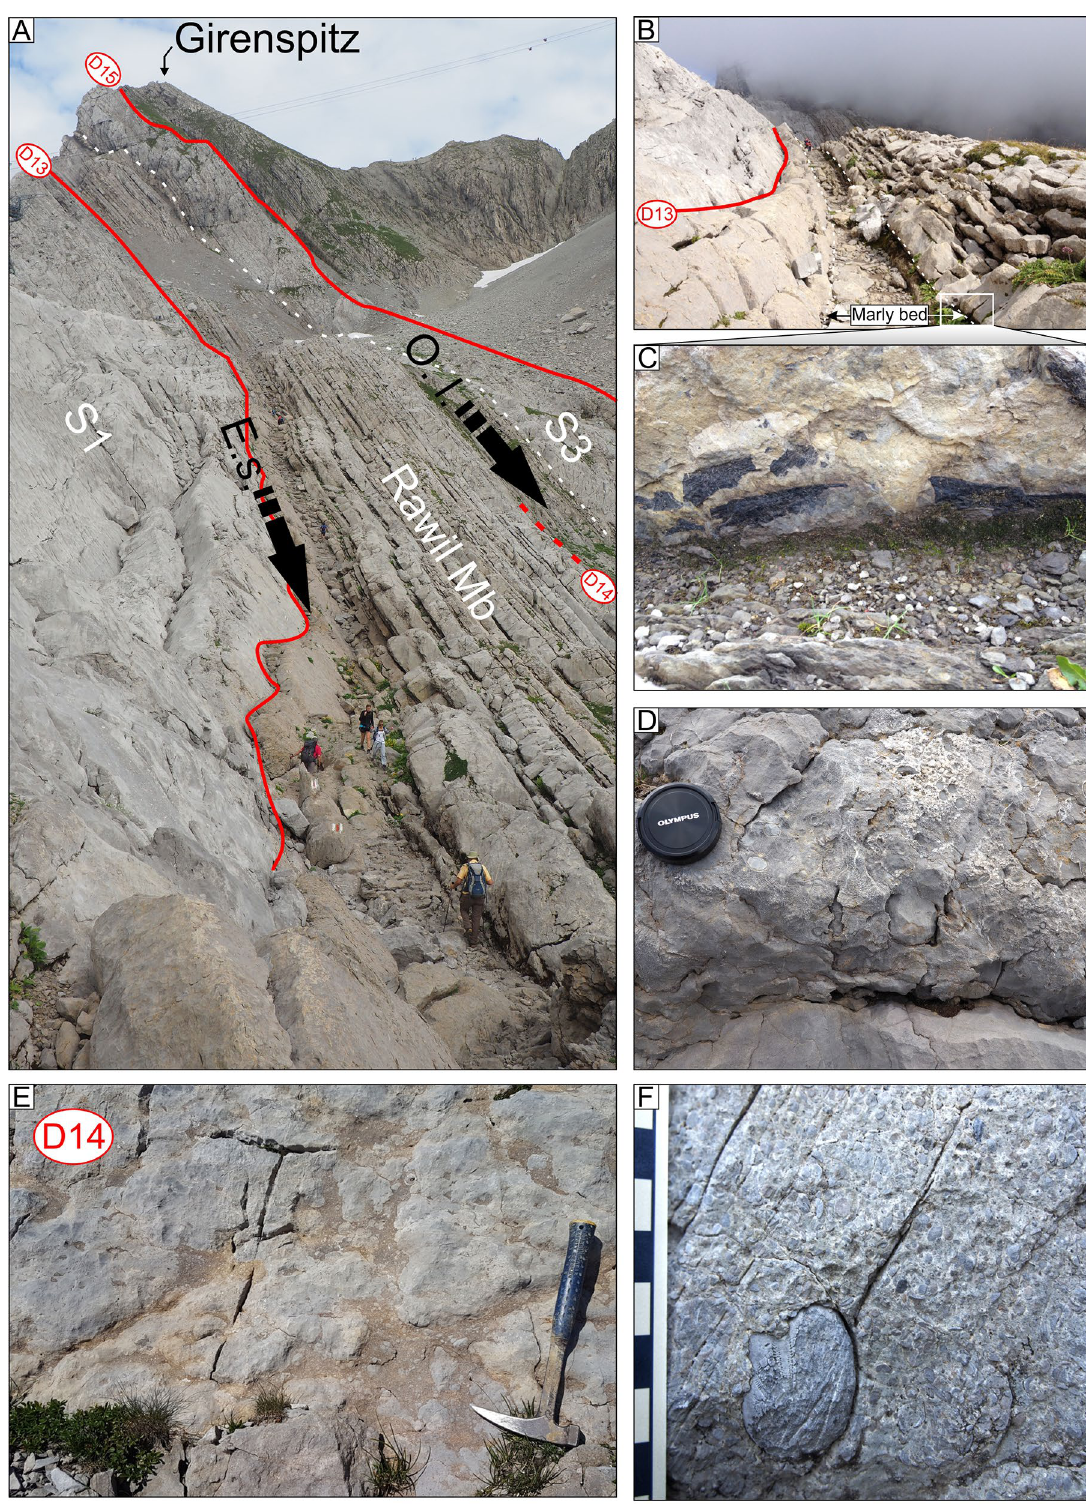
Fig. 5 A Overview of the Tierwis-Grauchopf section of unit S1, the Rawil Member and of unit S3. E.s. level. B Focus on the lower marly intercalation of the Rawil Member. C Focus on the tree trunks (ca. 50 cm long) at the top of the lower marly intercalation. D Focus on the coral carpets above the lower marly intercalations. E Focus on the firmground at the base of the upper marly intercalations. F Focus on the Orbitolina -rich rudstone of the upper marly intercalation associated to Heteraster oblongus (Brongniart,